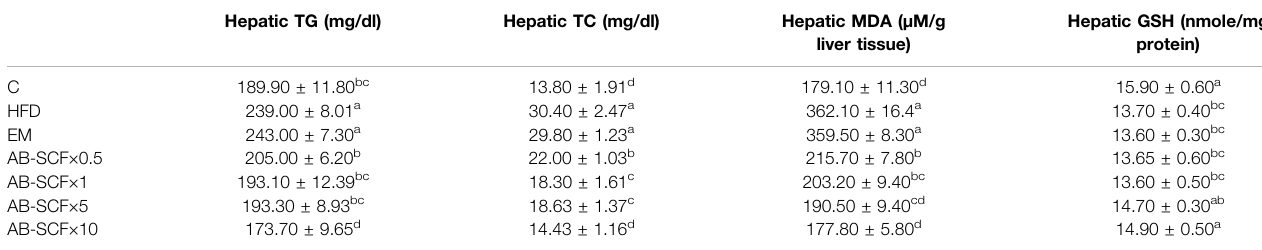
TABLE 3 | Hepatic triglyceride, total cholesterol, GSH and MDA among hyperlipidemic hamsters administrated with